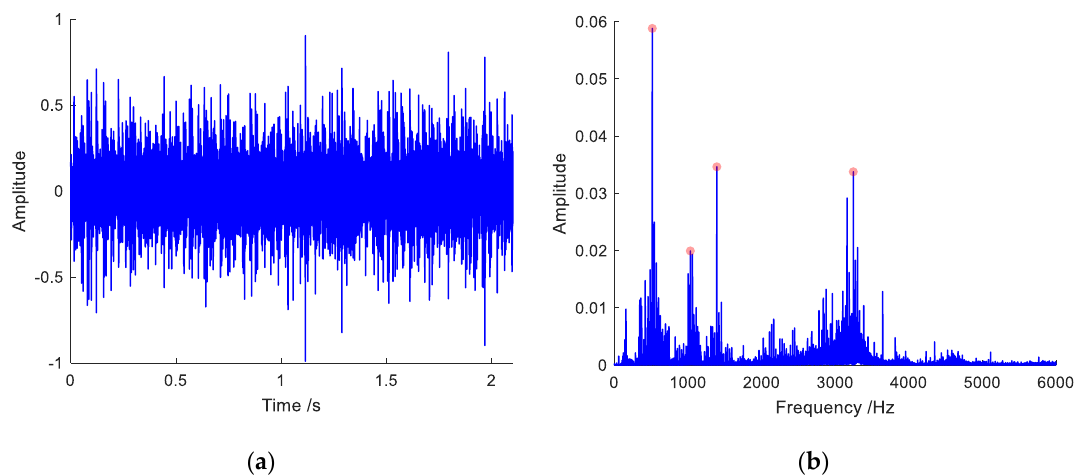
Figure 13. The original vibration signal: ( a ) The waveform incorporates a few impulses; ( b ) in the spectrum, prominent resonance bands stand out at around 500 Hz, 1000 Hz, 1300 Hz, and 3250 Hz.